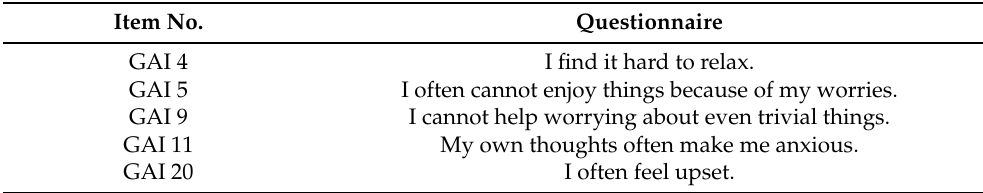
Table 2. Partial list of questionnaire items in K-GAI. Item